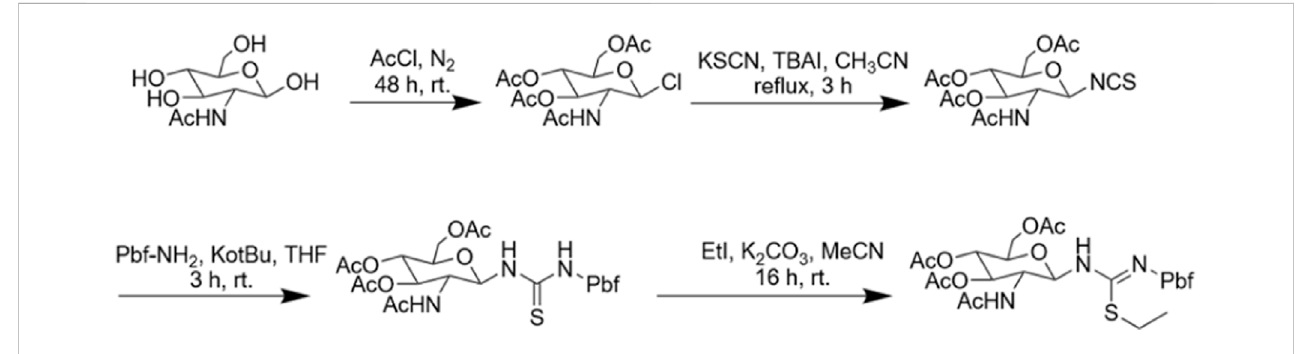
FIGURE 6 Synthesis routes of glycosyl